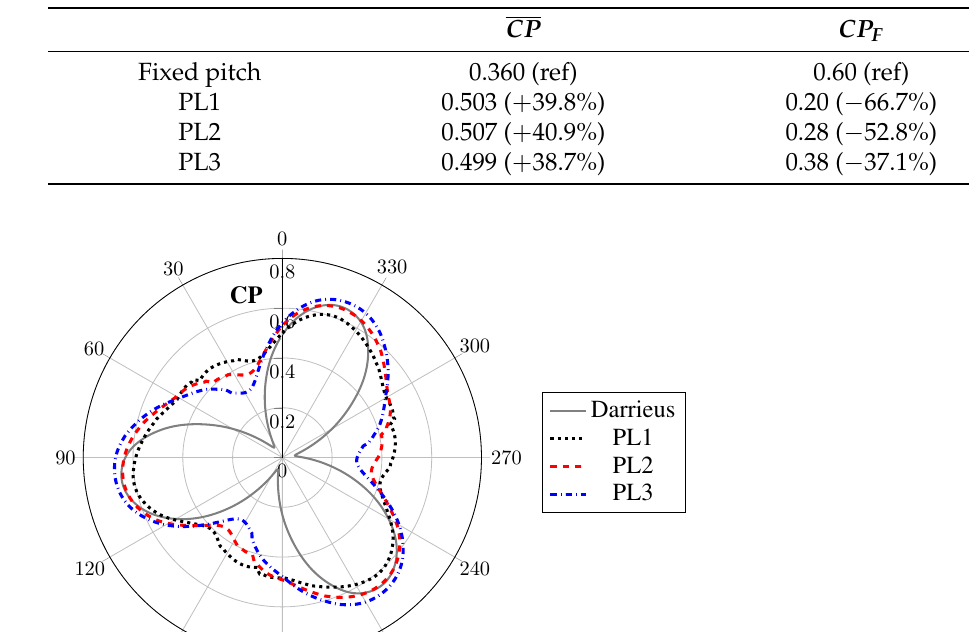
CP min ) values for the −